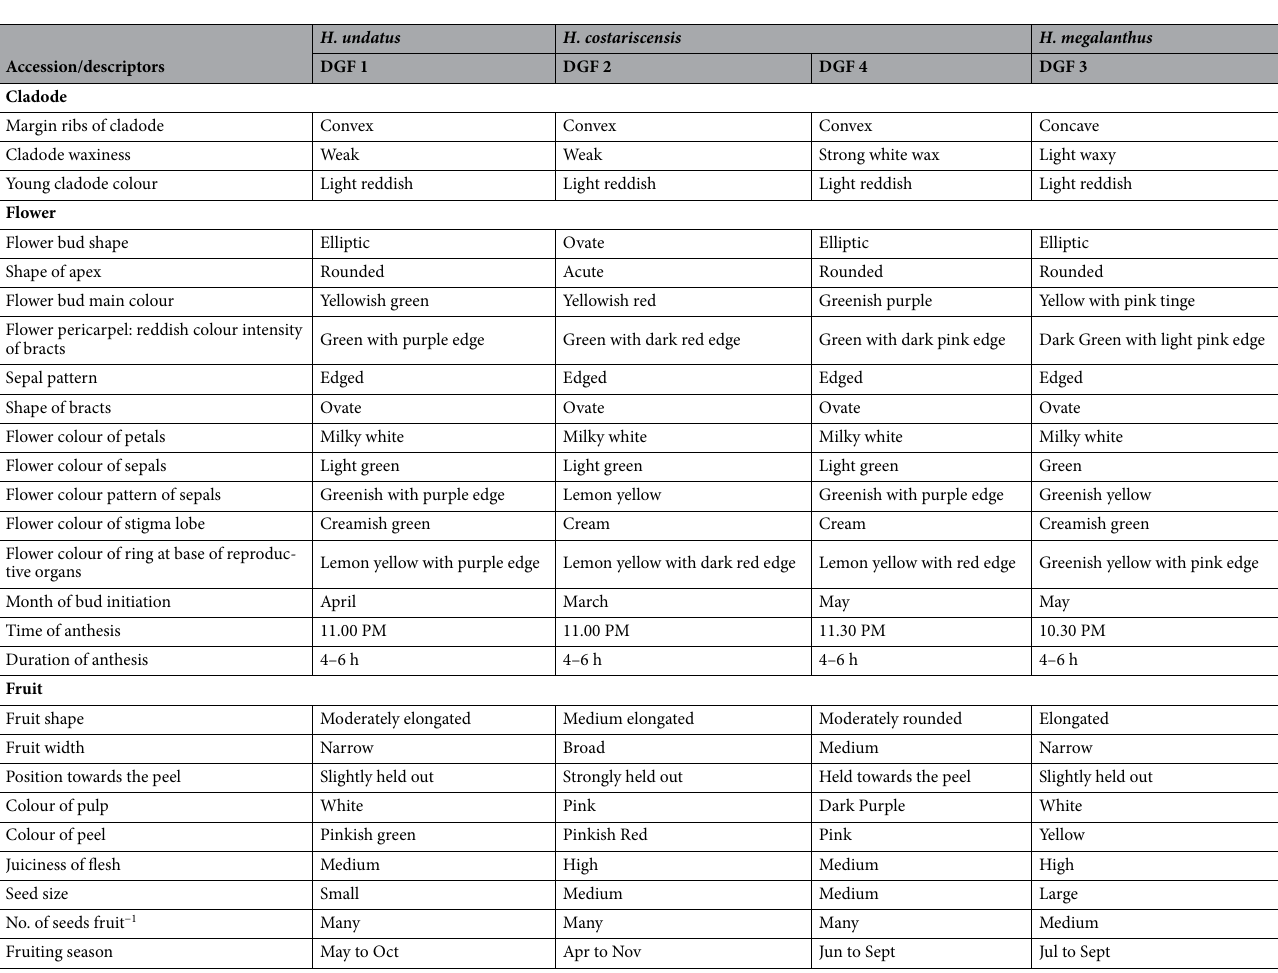
Table 2. Characterization of three dragon fruit ( Hylocereus ) species with 26 qualitative traits of cladode, flower and fruit in Andaman and Nicobar